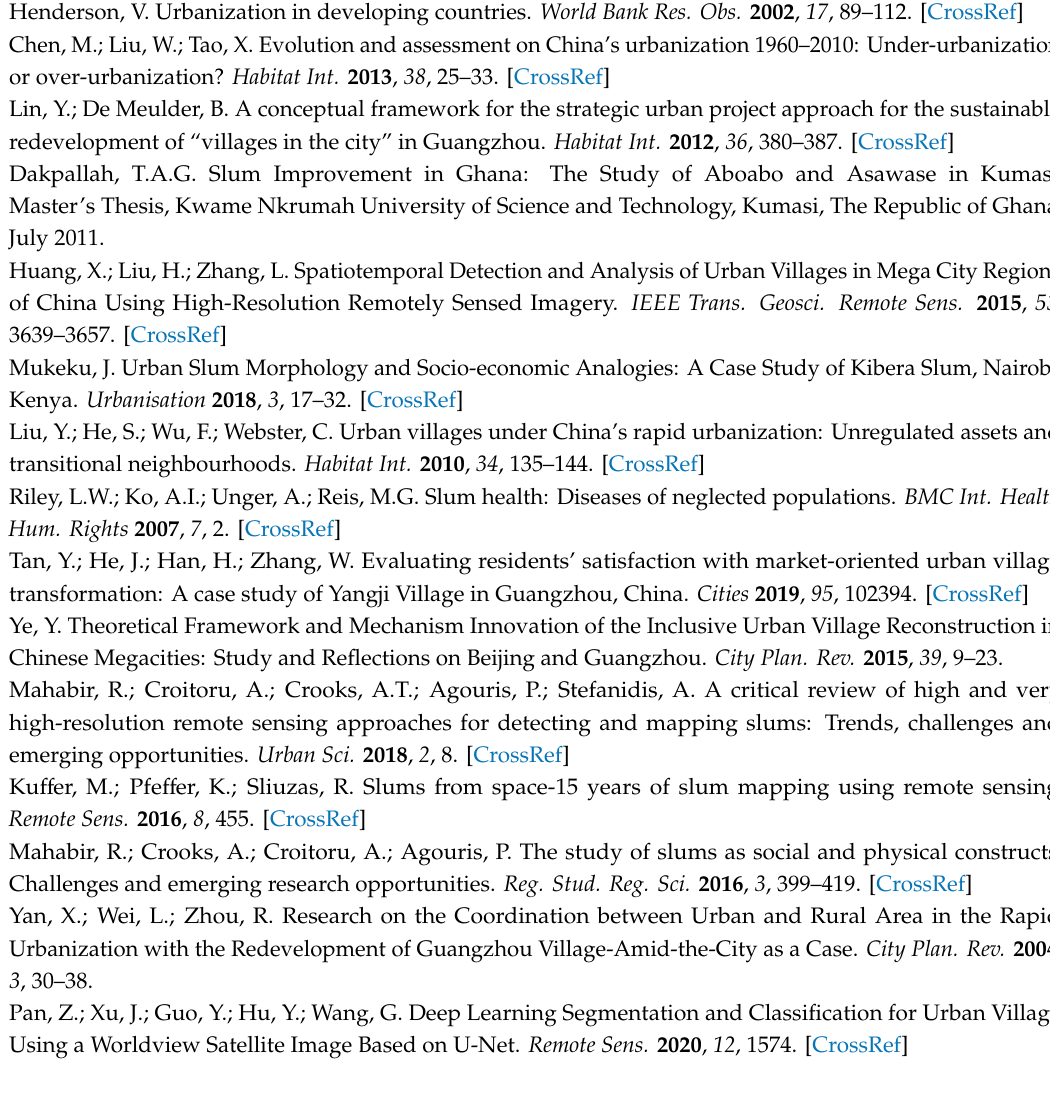
Figure S1: Informal urban settlements in some countries: (a) Rocinha, Rio, Brazil; (b) Dharavi, Mumbai, India; (c) Kibera, Nairobi, Kenya; (d) Shipai village, Guangzhou, Guangdong, China (source: Google